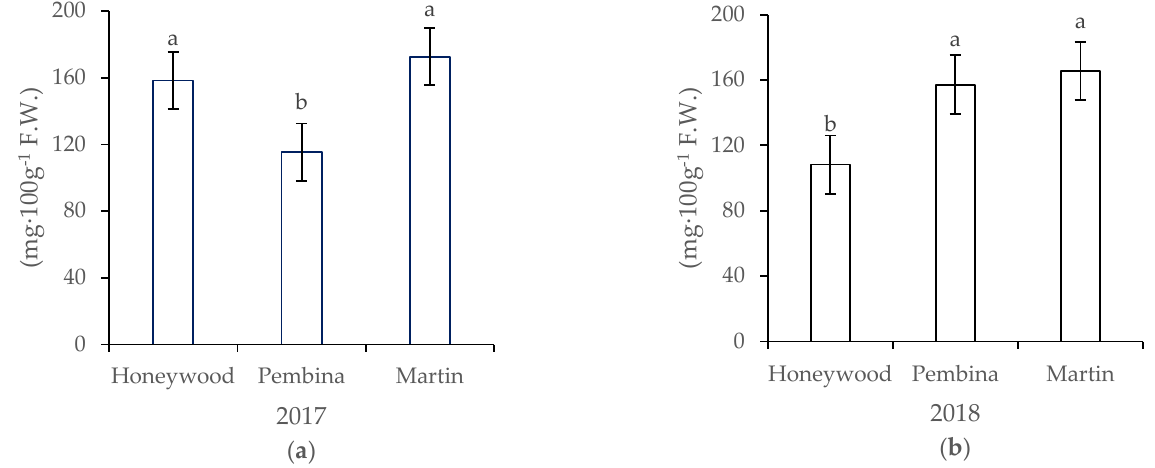
Figure 9. Total anthocyanin content in the fruits of the studied cultivars in ( a ) 2017 and ( b ) 2018. Values with different letters are significantly different within a year.